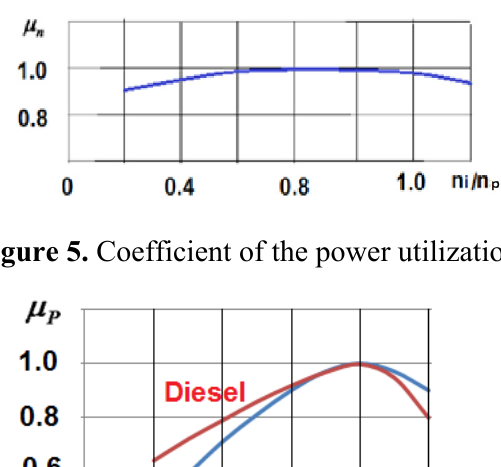
Figure 4. Coefficient of the engine speed mode (same for diesel and gasoline engines).